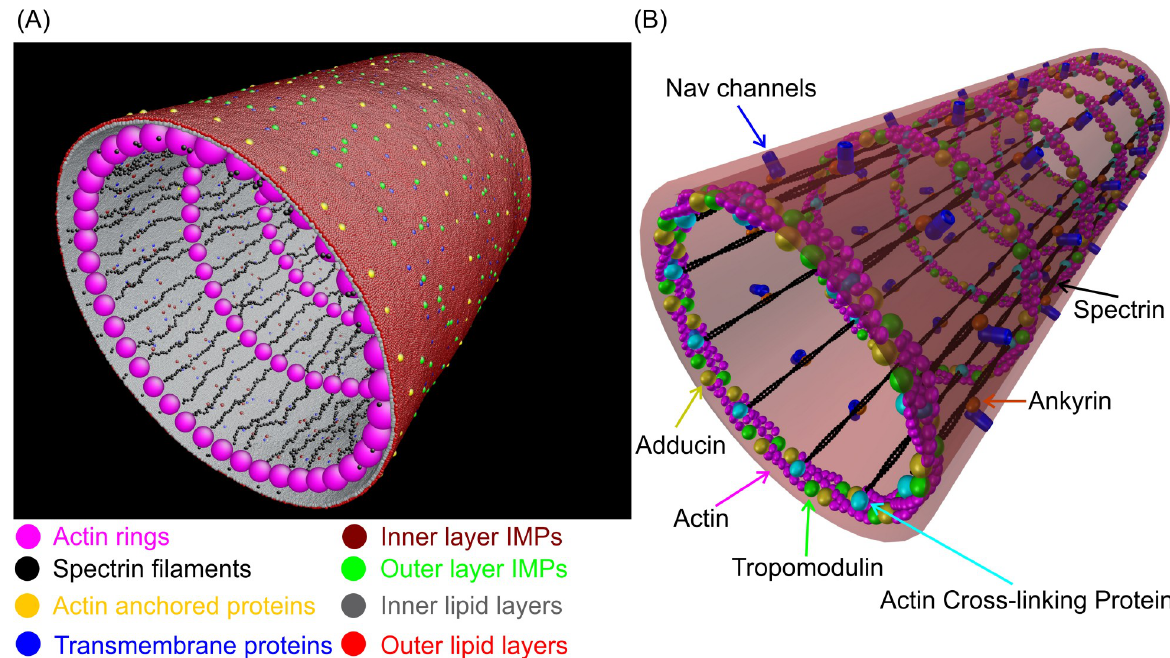
Fig 1. Computational and schematic model of the APM. (A) Computational model of the APM showing different structural components. (B) Schematic illustration of the APM based on super-resolution microscopy results of the periodic APMS structure. Ankyrin-associated Na v channels anchor the phospholipid bilayer to the membrane